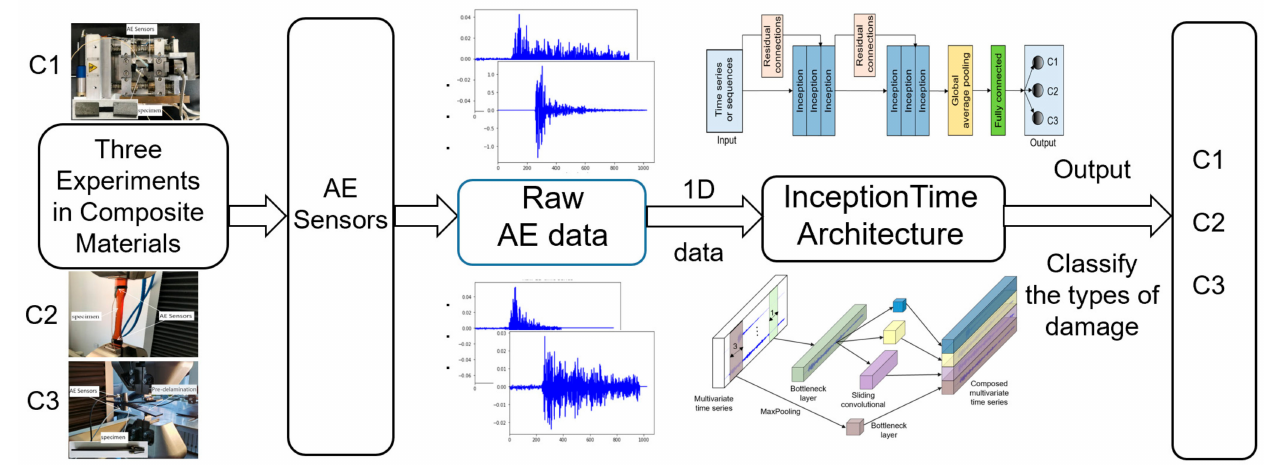
Figure 6. Schema of the InceptionTime deep learning model based on the raw AE time series data damage classification of composite materials.